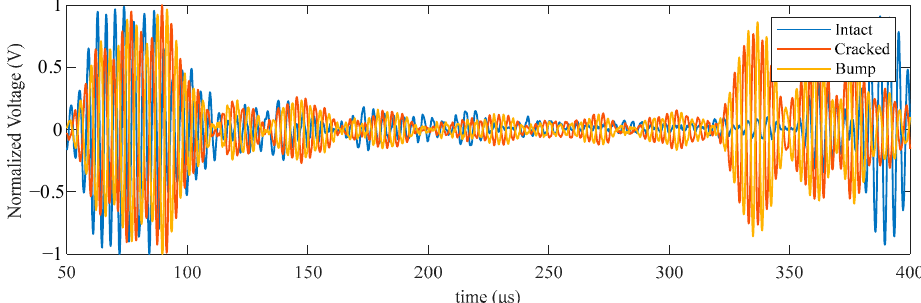
Figure 8. The UGW signals obtained by FBGs under different rail conditions.